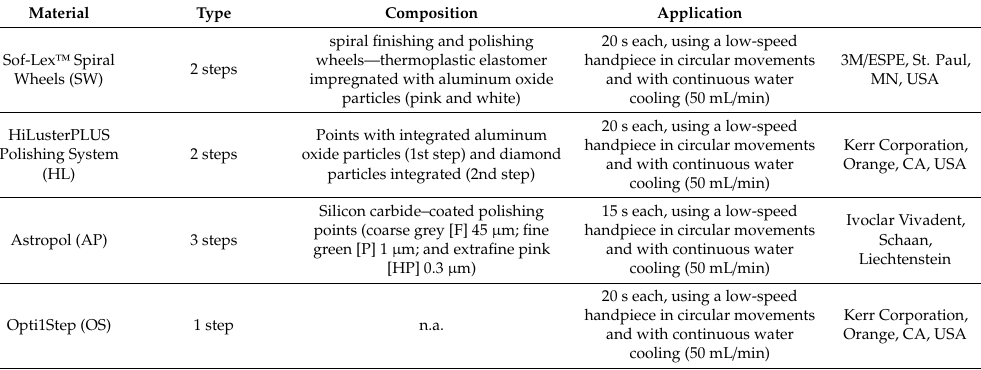
Table 2. Chemical composition and instructions for use of the tested finishing / polishing systems. n.a.—not